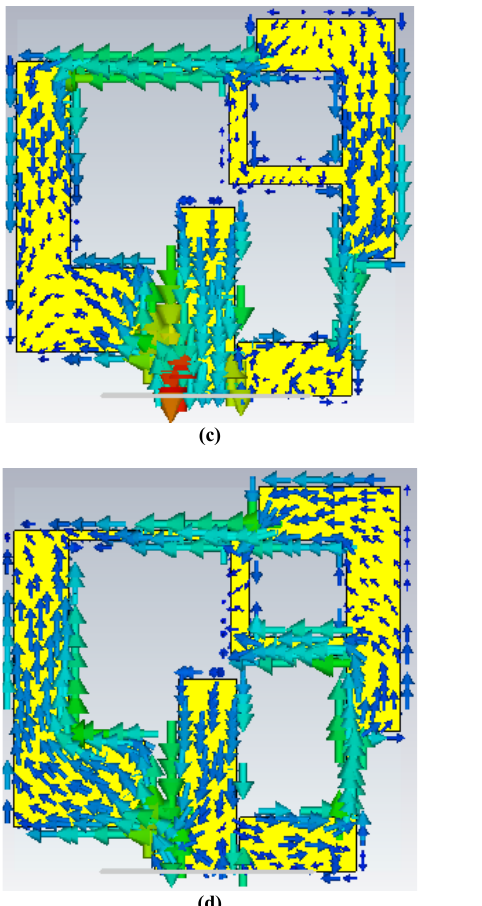
Fig. 13. Computer-generated surface current spreading at 5.8 GHz: (a) 0°; (b) 90°; (c) 180° and (d) 270°.